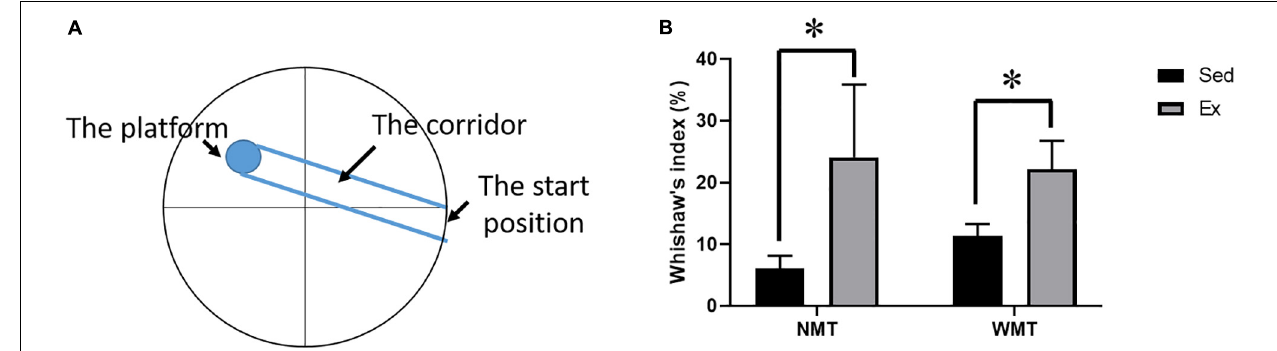
FIGURE 6 | Search strategies in different groups. (A) Scheme of maze configuration showing the corridor. (B) Different search strategies among groups. Mice in exercise (Ex) groups, including NMT + Ex and WMT + Ex groups, prefer a direct search strategy with more percent quadrant time in the corridor (connecting the start position with the platform) before the first entry to the platform. Data are graphed as means ± SEM ( n = 8–13); Data analysis used two-way ANOVA. ∗ p < 0.05.